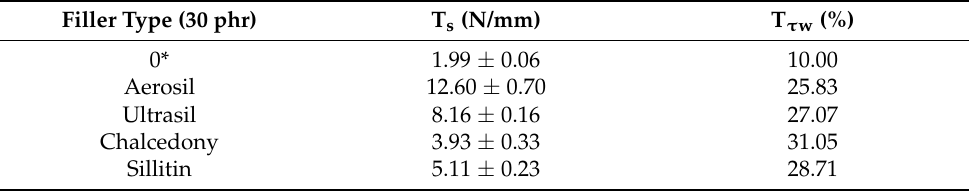
Table 8. Selected properties of unfilled and filled CR/BR/nano-Fe 2 O 3 vulcanizates. Filler Type (30 phr)